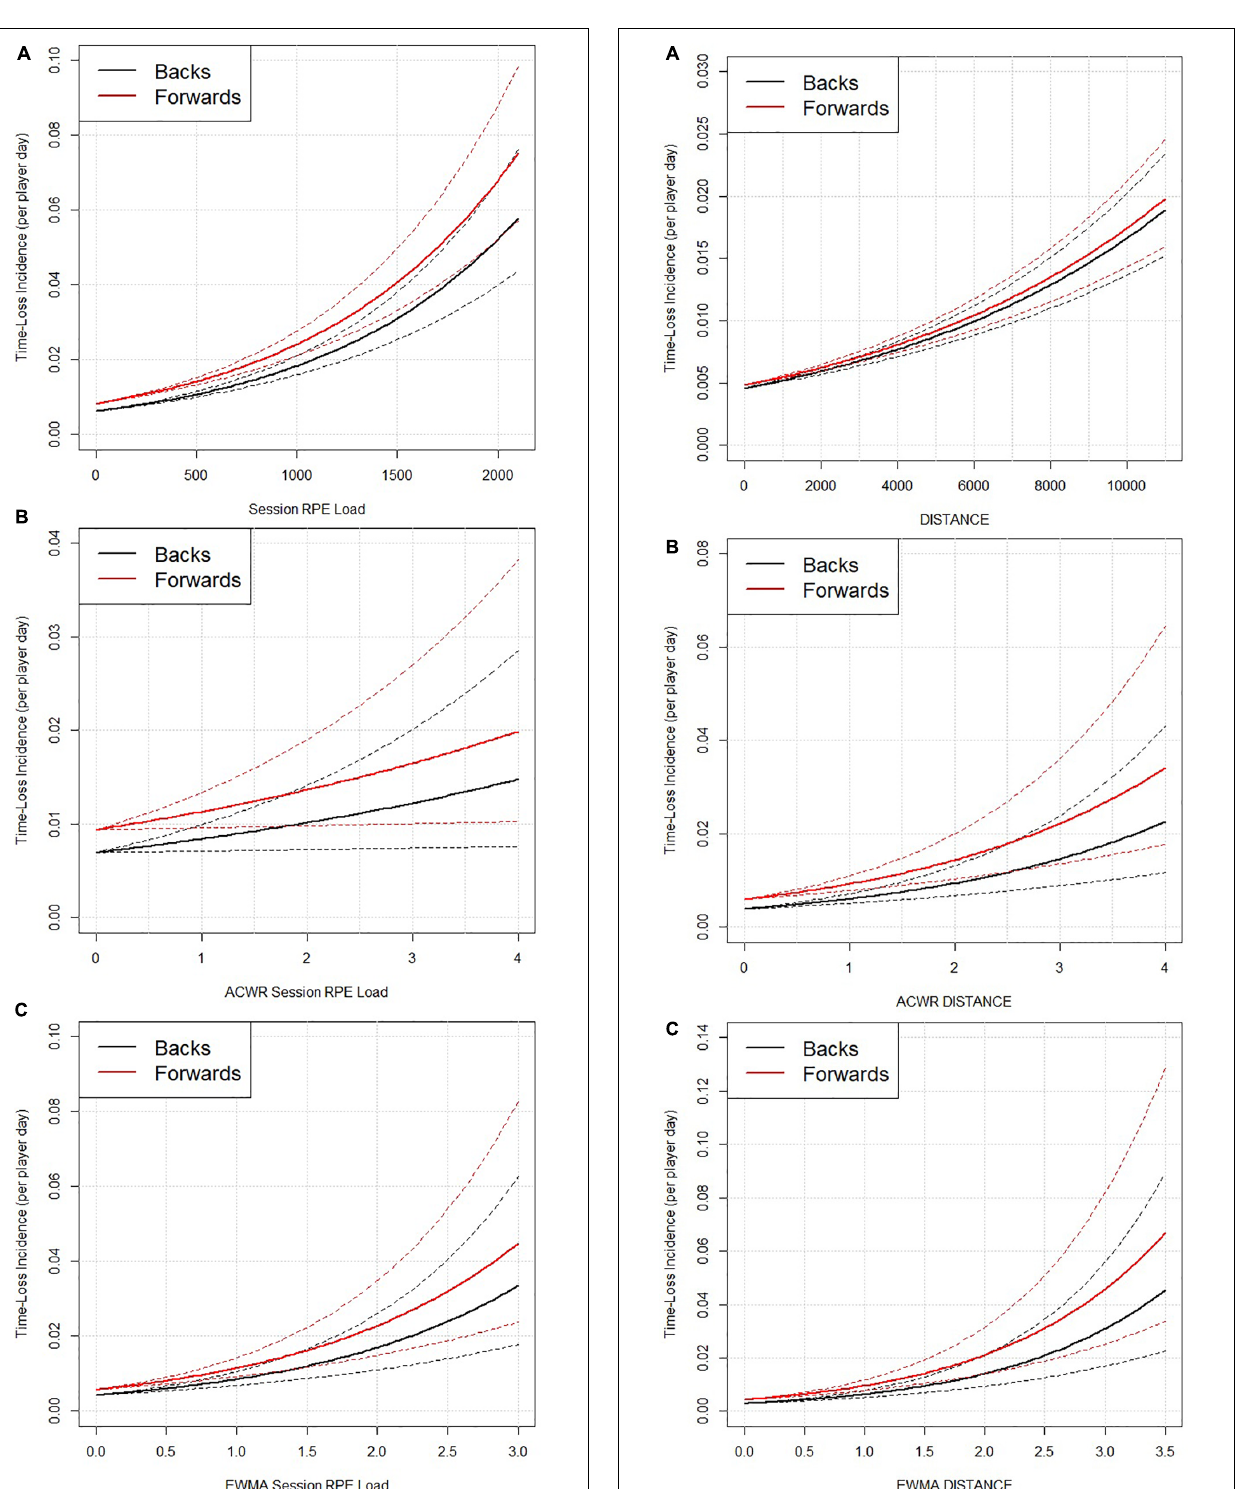
Frontiers in Physiology |